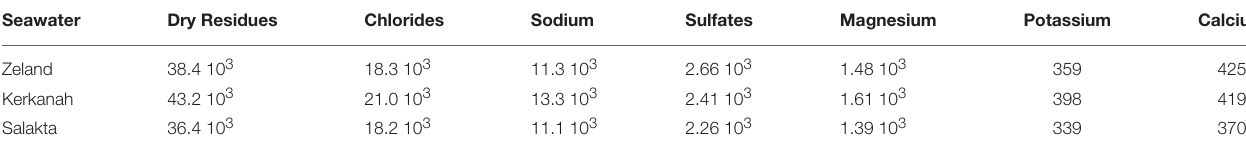
Frontiers in Chemistry |